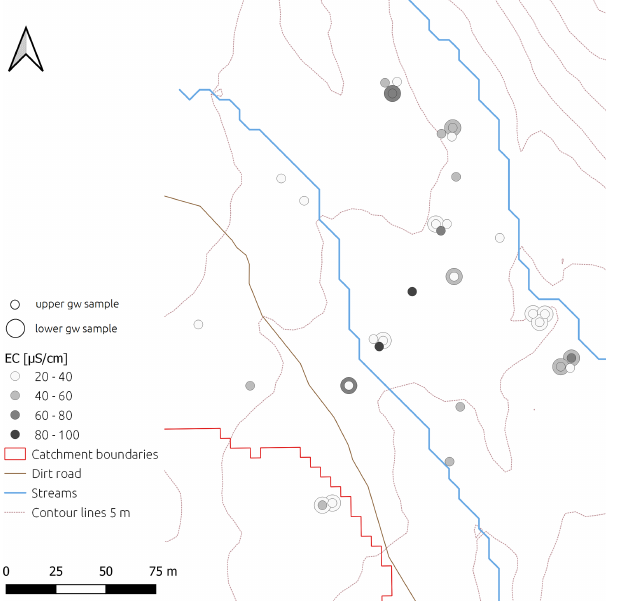
Figure 11. Map of δ 2 H of the groundwater samples taken near the water table (small circle; upper groundwater sample) and the bottom of the well (larger circle; lower groundwater sample) for the wells in study area A (also known as the C6 catchment). Where two circles are shown, the outer circle represents the groundwater sample taken from the bottom of the well and the inner circle the groundwater taken near the water